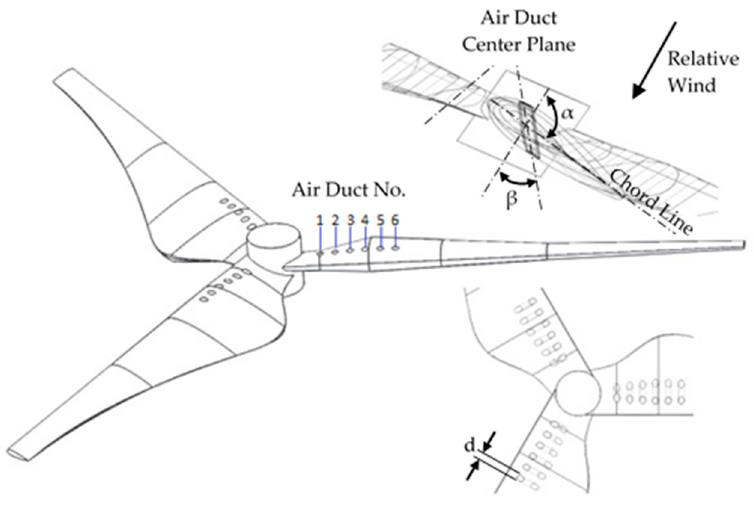
Figure 1. Horizontal axis wind turbine with duct.